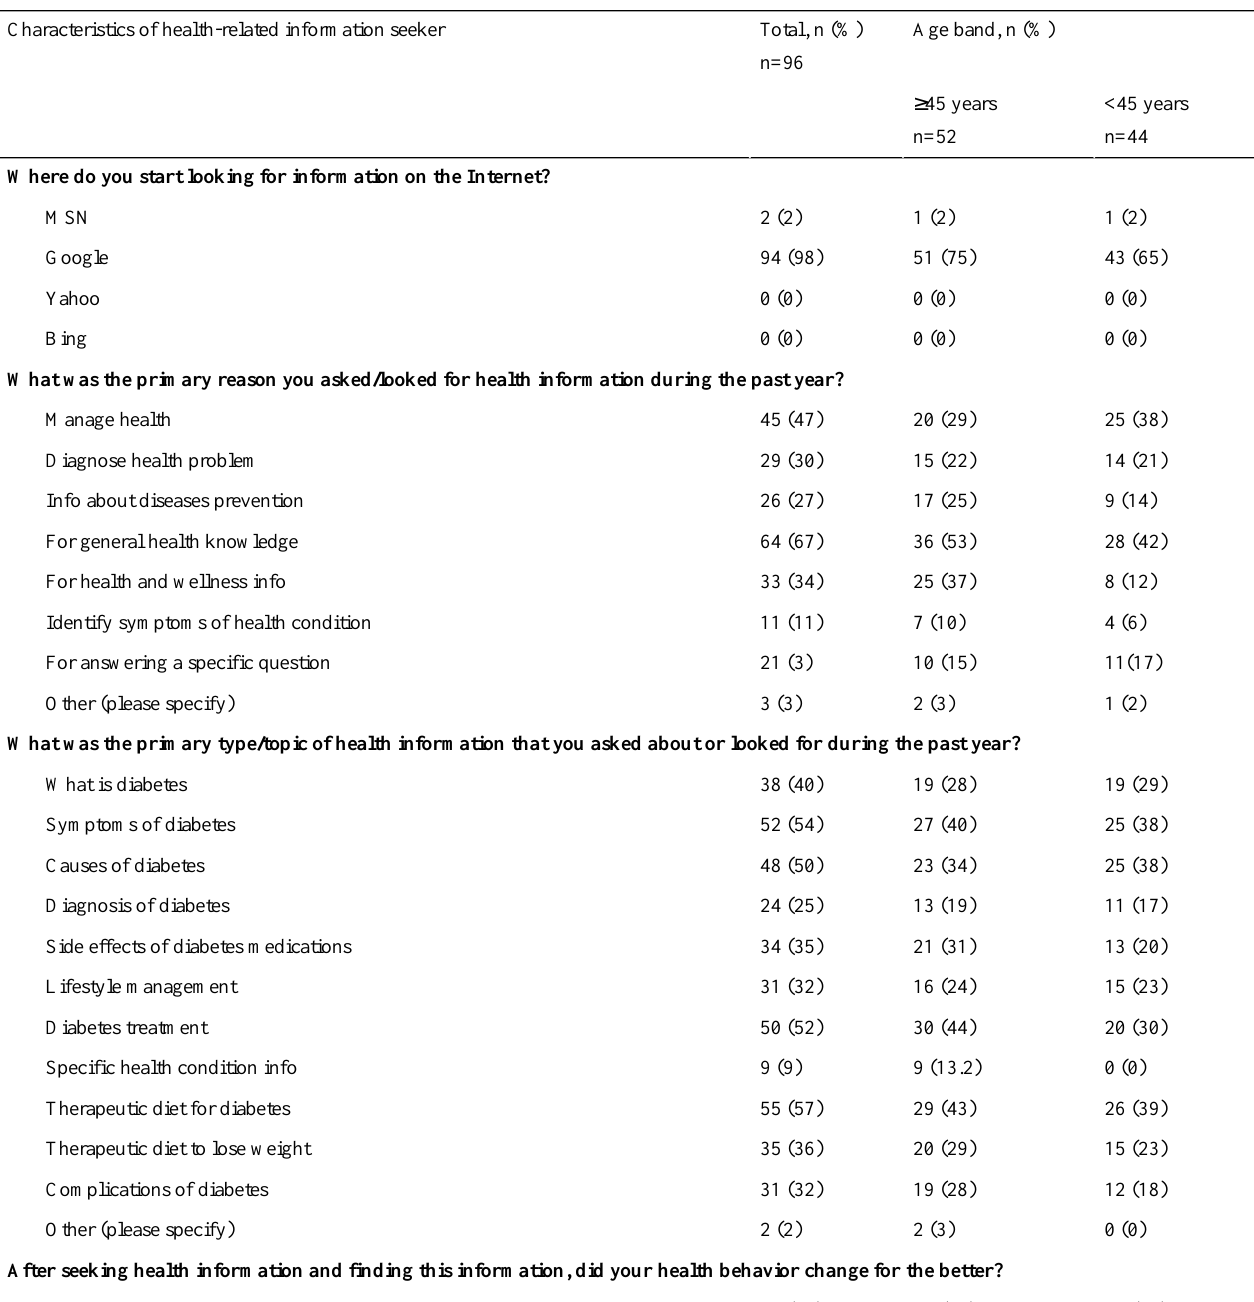
Table 3. Characteristics of online health-related information seekers included in the